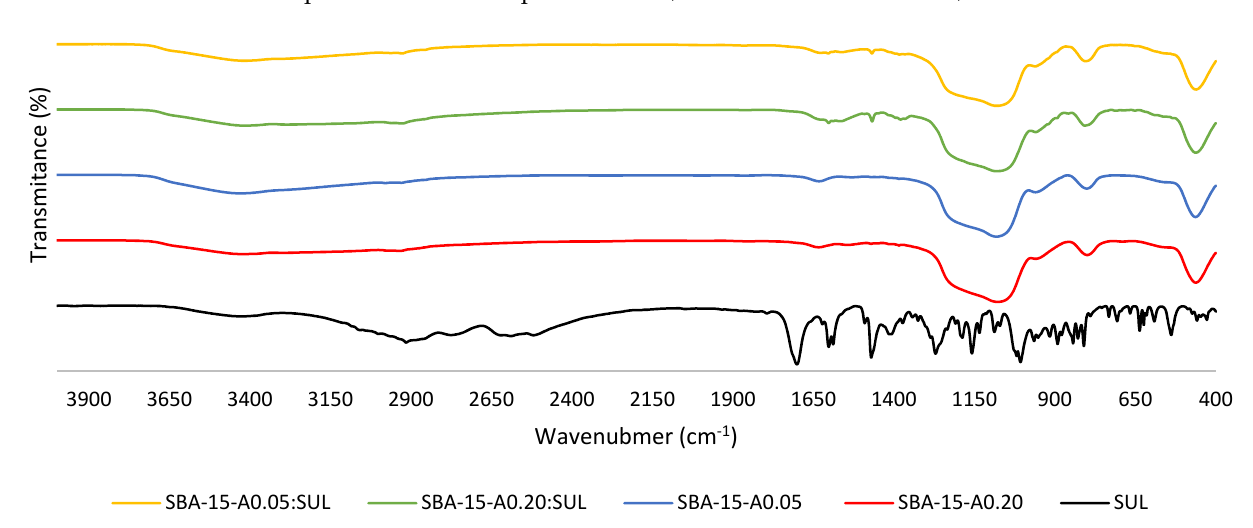
Figure 5. FT-IR spectra of SUL, SBA-15-A 0.05 , SBA-15-A 0.20 , SBA-15-A 0.05 :SUL, and SBA-15-A 0.20 Figure 5. FT ‐ IR spectra of SUL, SBA ‐ 15 ‐ A 0.05 , SBA ‐ 15 ‐ A 0.20 , SBA ‐ 15 ‐ A 0.05 :SUL, and SBA ‐ 15 ‐ A 0.20 :SUL.